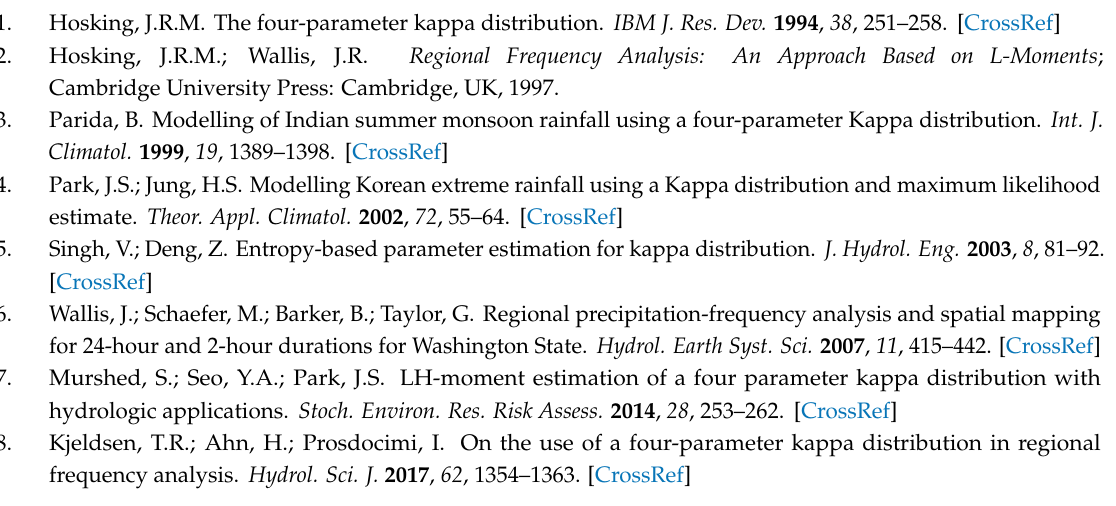
Table S1. Average CPU time per case (seconds/data) using the Intel(R) Core(TM) i5-6300HQ CPU @ 2.30 GHz (RAM 8 GB). R program. R code to calculate the Bayesian estimates of the four-parameter kappa